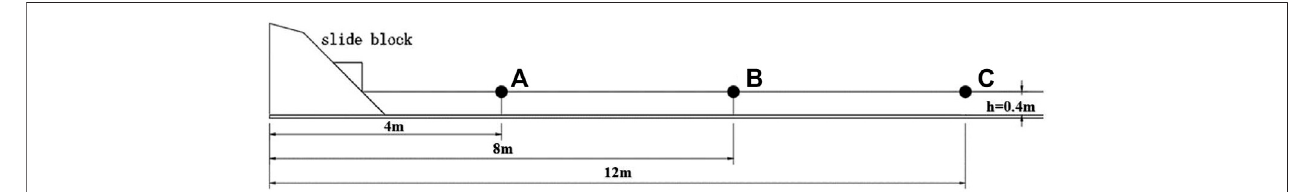
FIGURE 1 | Numerical plot of the validation model (in